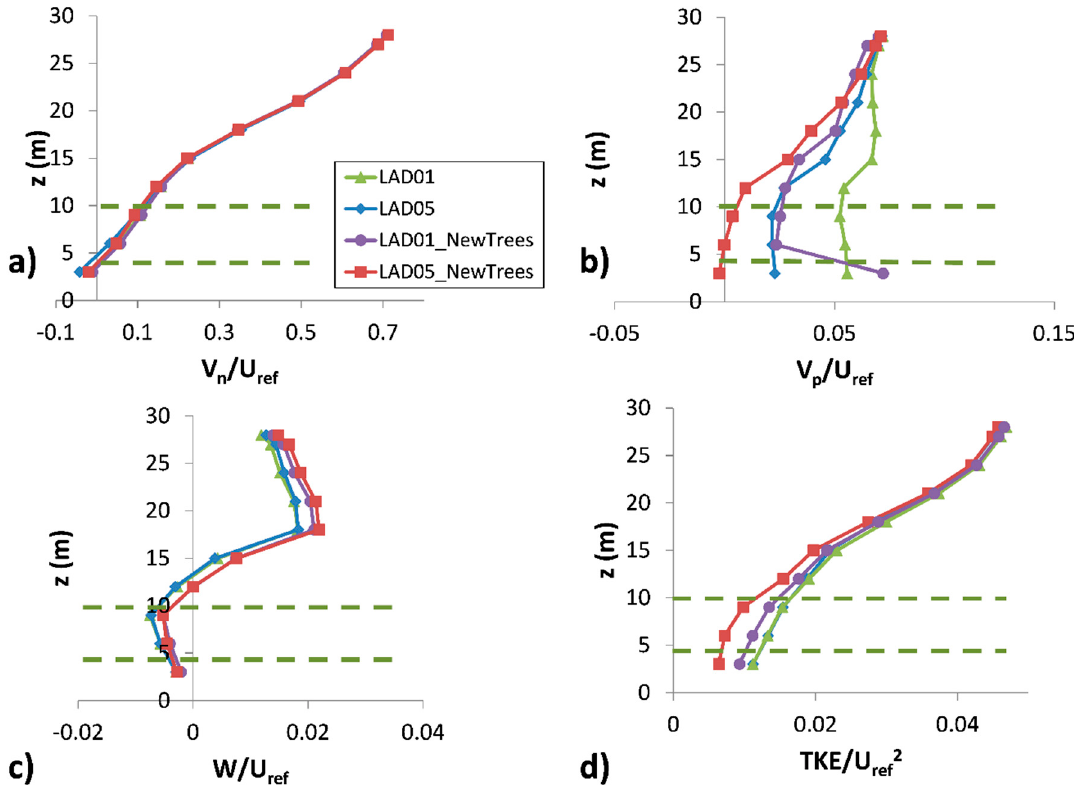
Figure 14. Vertical profiles of spatially-averaged flow properties within the study street. ( a ) Normalized wind speed normal to the street (V n / U ref ); ( b ) normalized wind speed parallel to the street (V p / U ref ); ( c ) normalized vertical wind speed (W / U ref ); ( d ) normalized turbulent kinetic energy (TKE / U ref ). Dashed lines indicate the crown location of new trees.